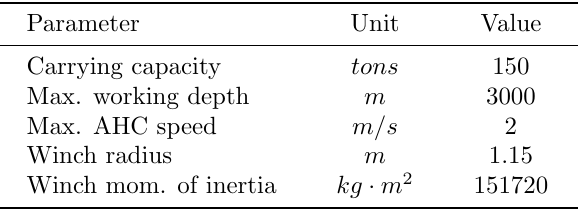
Table 2: Offshore crane winch